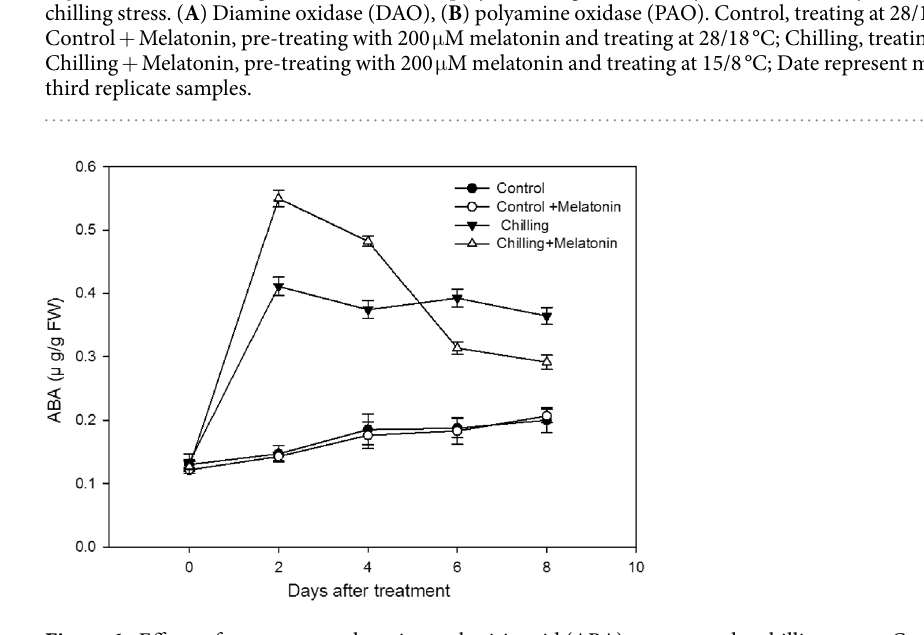
Figure 6. Effects of exogenous melatonin on abscisic acid (ABA) content under chilling stress. Control, treating at 28/18 °C; Control + Melatonin, pre-treating with 200 μ M melatonin and treating at 28/18 °C; Chilling, treating at 15/8 °C; Chilling + Melatonin, pre-treating with 200 μ M melatonin and treating at 15/8 °C; Date represent means ± SD of third replicate